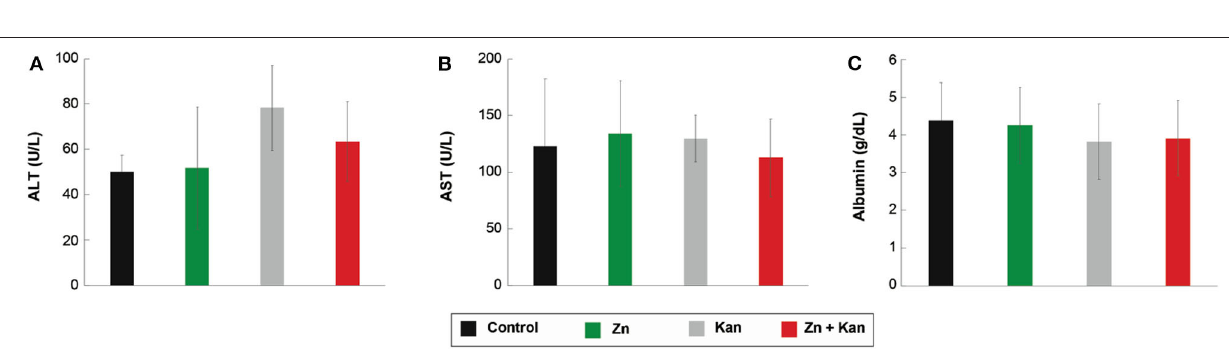
their native toxicity to cells, eukaryotes, and prokaryotes.